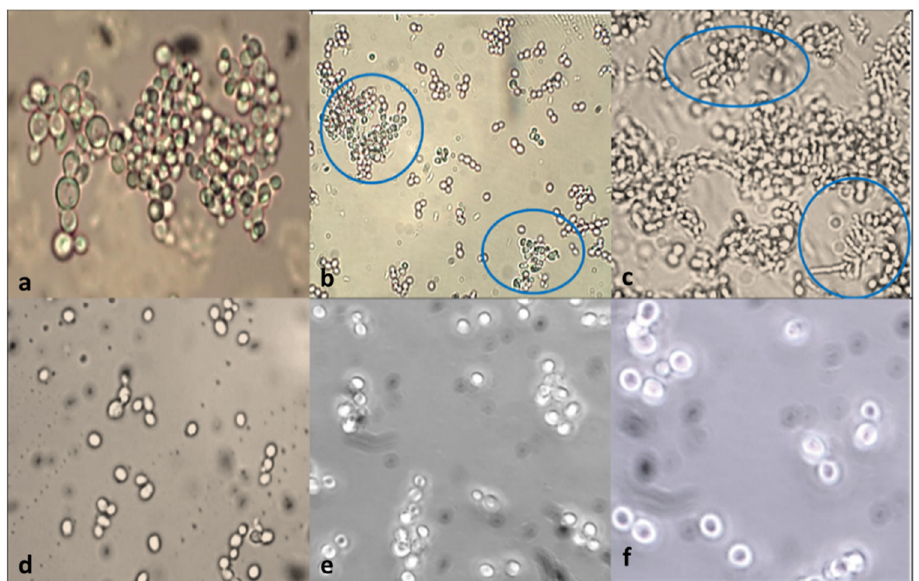
significantly different values ( p < 0.05).